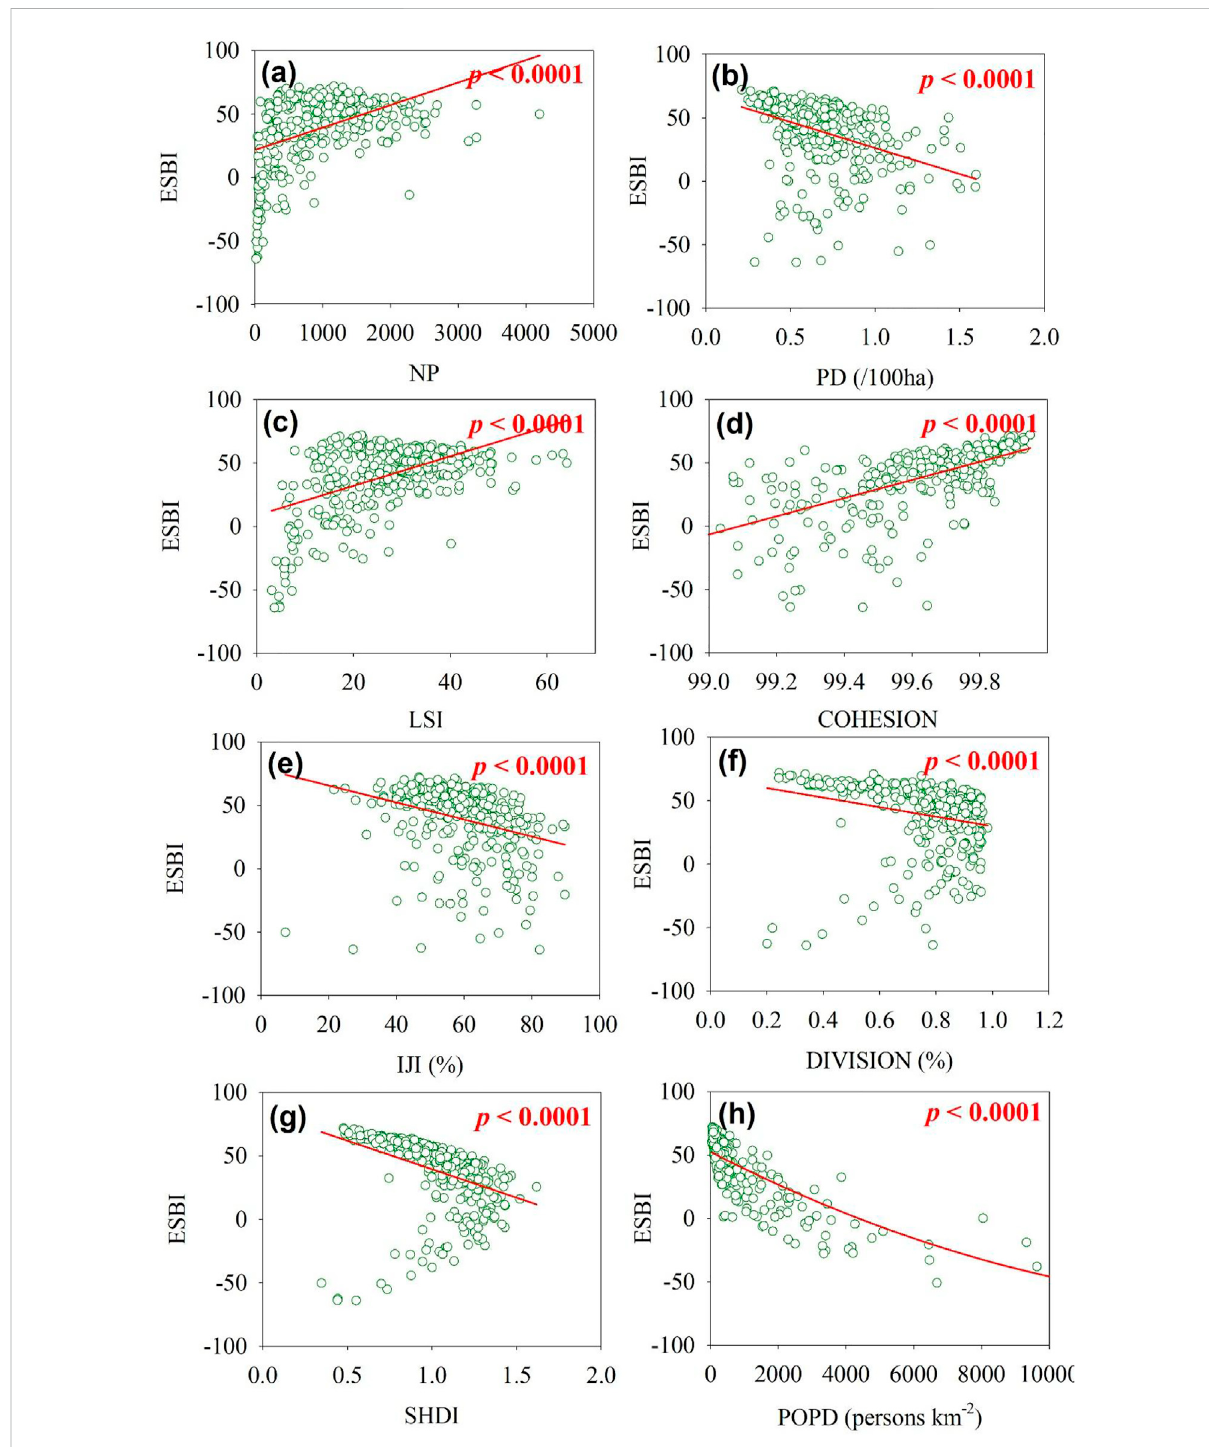
FIGURE 8 Associations between the ESBI and landscape and socioeconomic variables: (A) NP, (B) PD, (C) LSI, (D) COHESION, (E) IJI, (F) DIVISION, (G) SHDI, and (H)